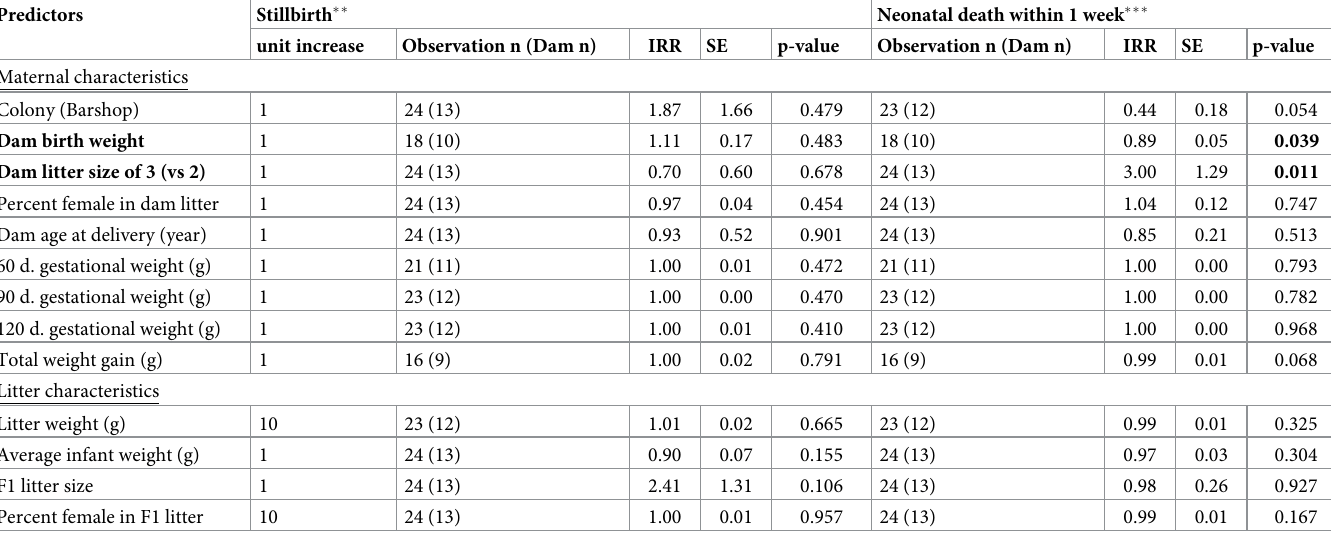
Table 3. Poisson univariate models � predicting stillbirth and neonatal